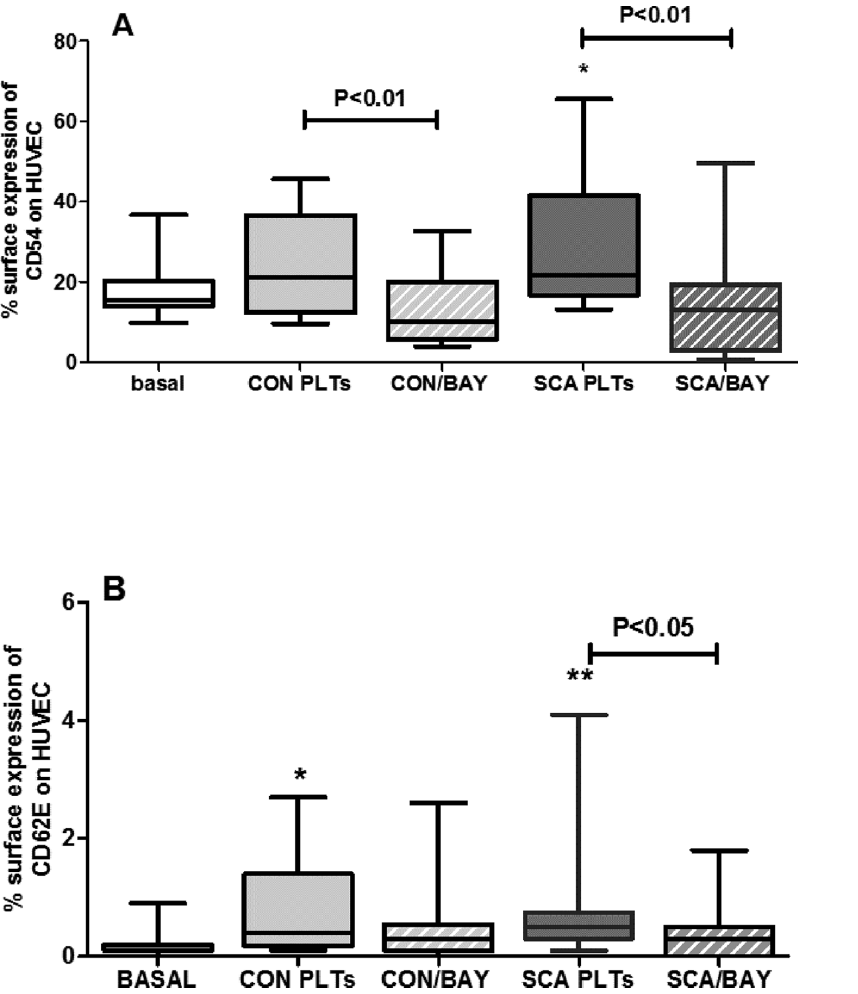
Figure 7. Effect of inhibition of the NF- k B pathway on the induction of endothelial adhesion molecule expression by SCA PLTs. The expressions of (A) ICAM-1 (CD54) and (B) E-selectin (CD62E) were determined by flow cytometry on HUVEC (1 6 10 6 cells/well) following co-culture in direct contact with CON PLTs (N $ 13) or SCA PLTs (1 6 10 8 PLTs/well; N $ 14) in the presence or absence of BAY 11-7082 (20 m M; 4 h, 37 u C, 5% CO 2 ). *, P , 0.05; **, P , 0.01, compared to basal (N $ 12).